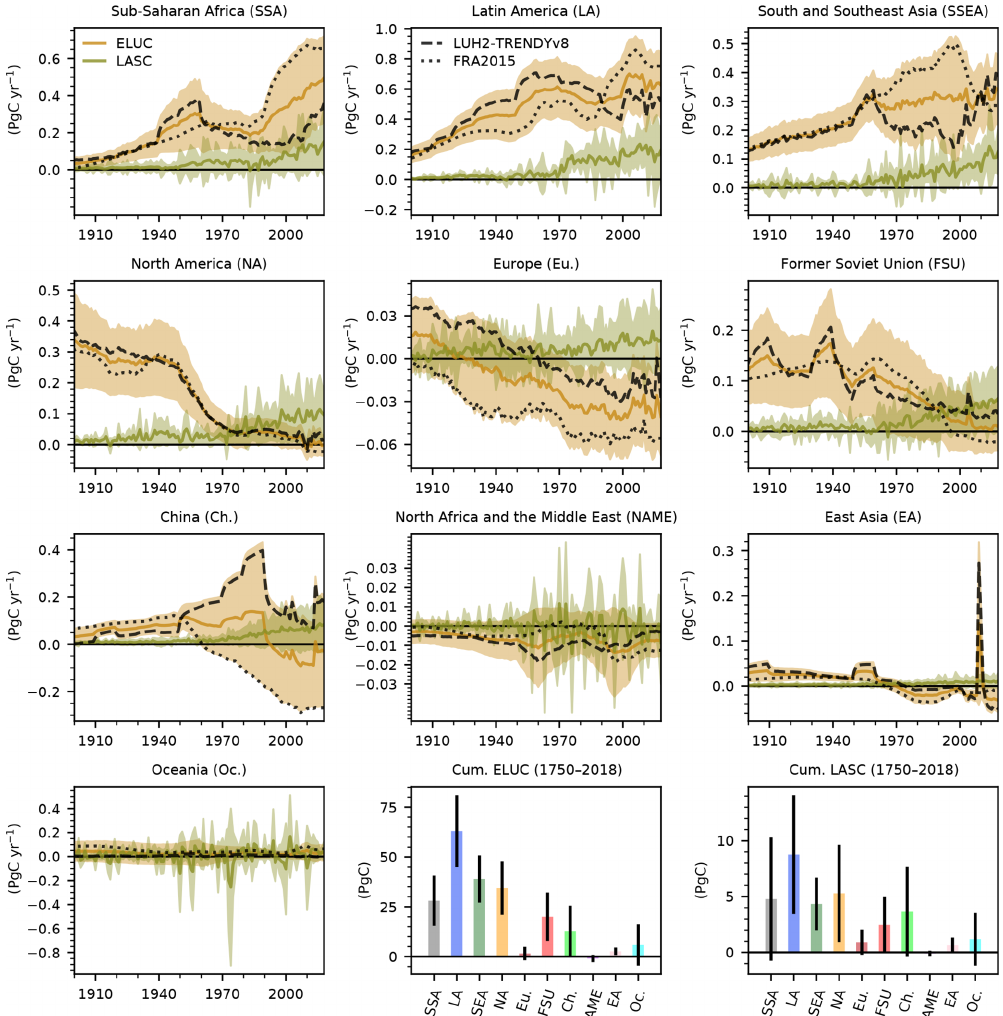
Figure 4. Regional breakdown of our best-guess estimates. Annual bookkeeping LULCC emissions (in brown) and LASC (in green) are shown, except in the last two panels where the regional cumulative bookkeeping LULCC emissions (ELUC) and LASC over the 1750–2018 period are shown. Shaded areas and uncertainty bars represent the 1 σ uncertainty range. To help identify regional discrepancies between LULCC driving data sets, we also separate the average estimates for the LUH2-GCB2019 (dashed black line) and FRA2015 (dotted black line) data sets (which are shown without their own uncertainty for